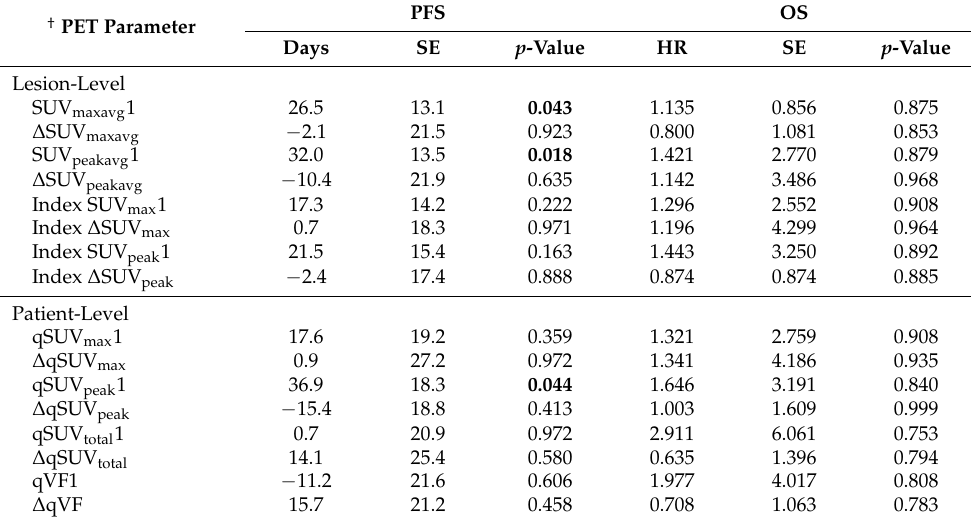
Table 4. Multivariate analysis of PET variables to PFS and OS ( p -values,